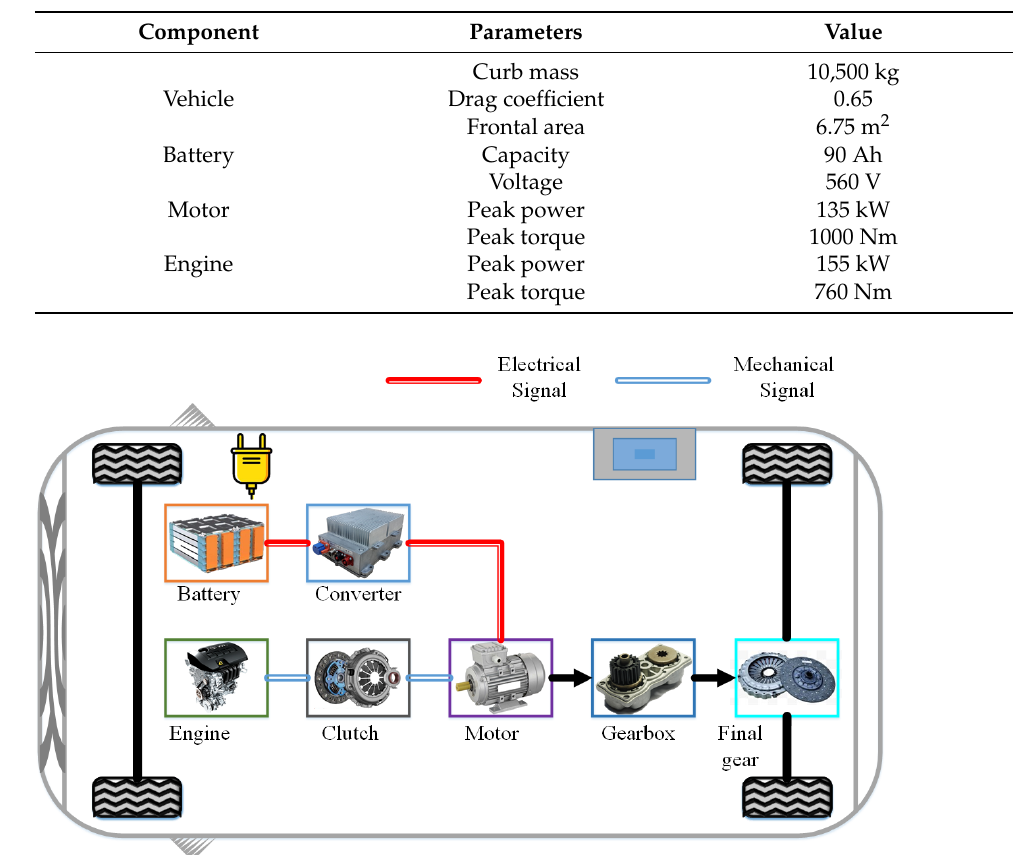
Table 1. Parameters of the PHEB.